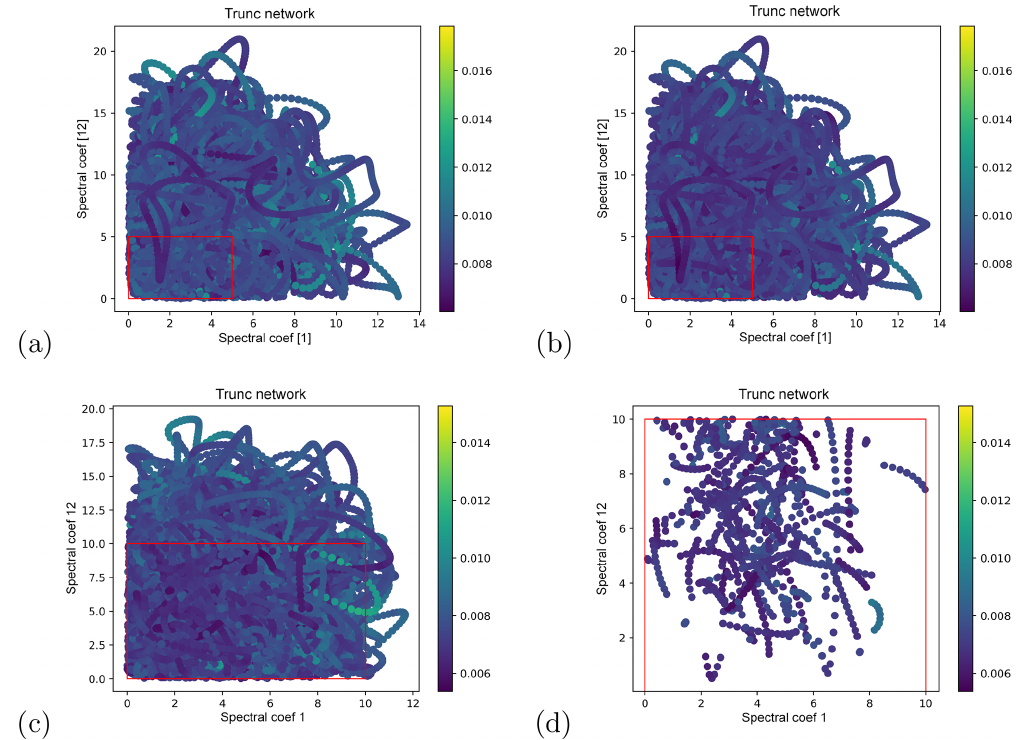
Figure 6. Networks trained only on part of the Lorenz95 phase space. Short-term forecast errors of the network trained on full training set (a) and a truncated set selected on a Poincaré section in spectral space (b) , projected onto said Poincaré section. The rectangle denotes the region of phase space left out from training. (c, d) Short-term forecast errors of a network trained on a truncated set selected on all 20 spectral components. (c) shows all points in the test set, (d) only the points that lie in the region cut out from